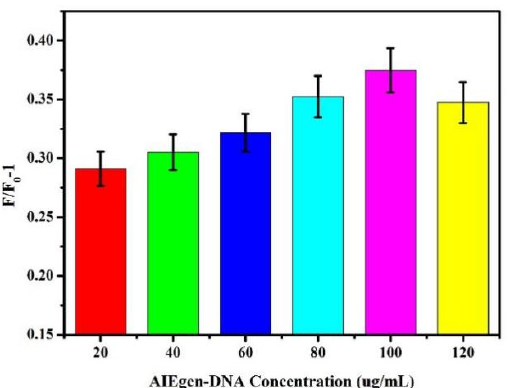
Figure 3. Effect of different concentrations of AIEgen-DNA on fluorescence intensity changes.